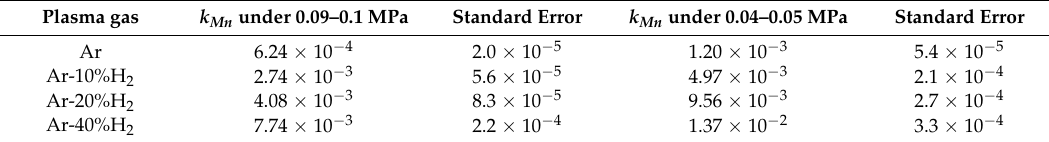
Table 1. The manganese reduction rate constant and its corresponding standard error.